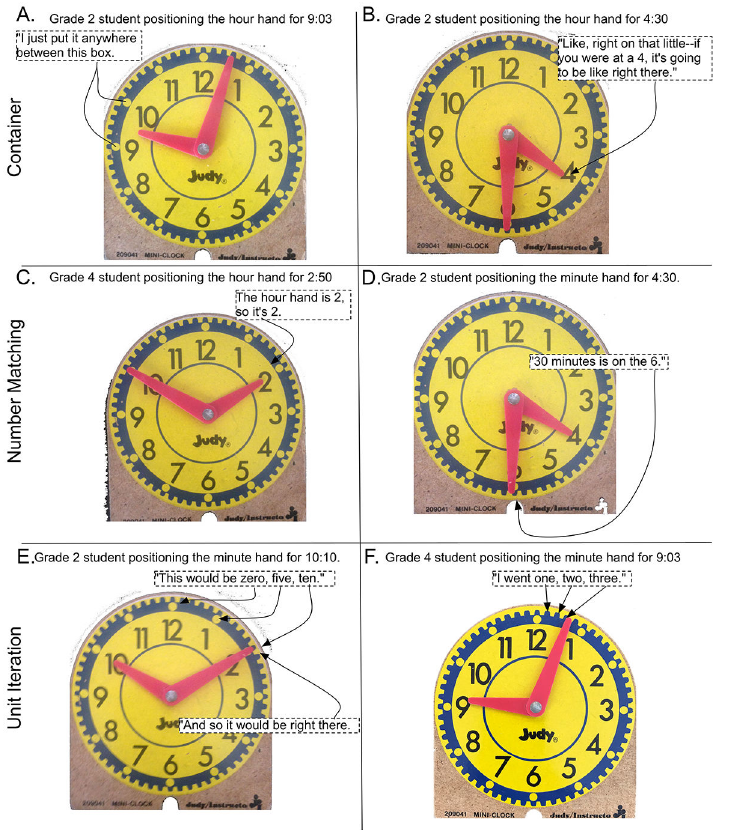
Figure 5. Students’ strategies to position hour and minute hands included (a-b) Container, (c-d) Number Matching, and (e-f)